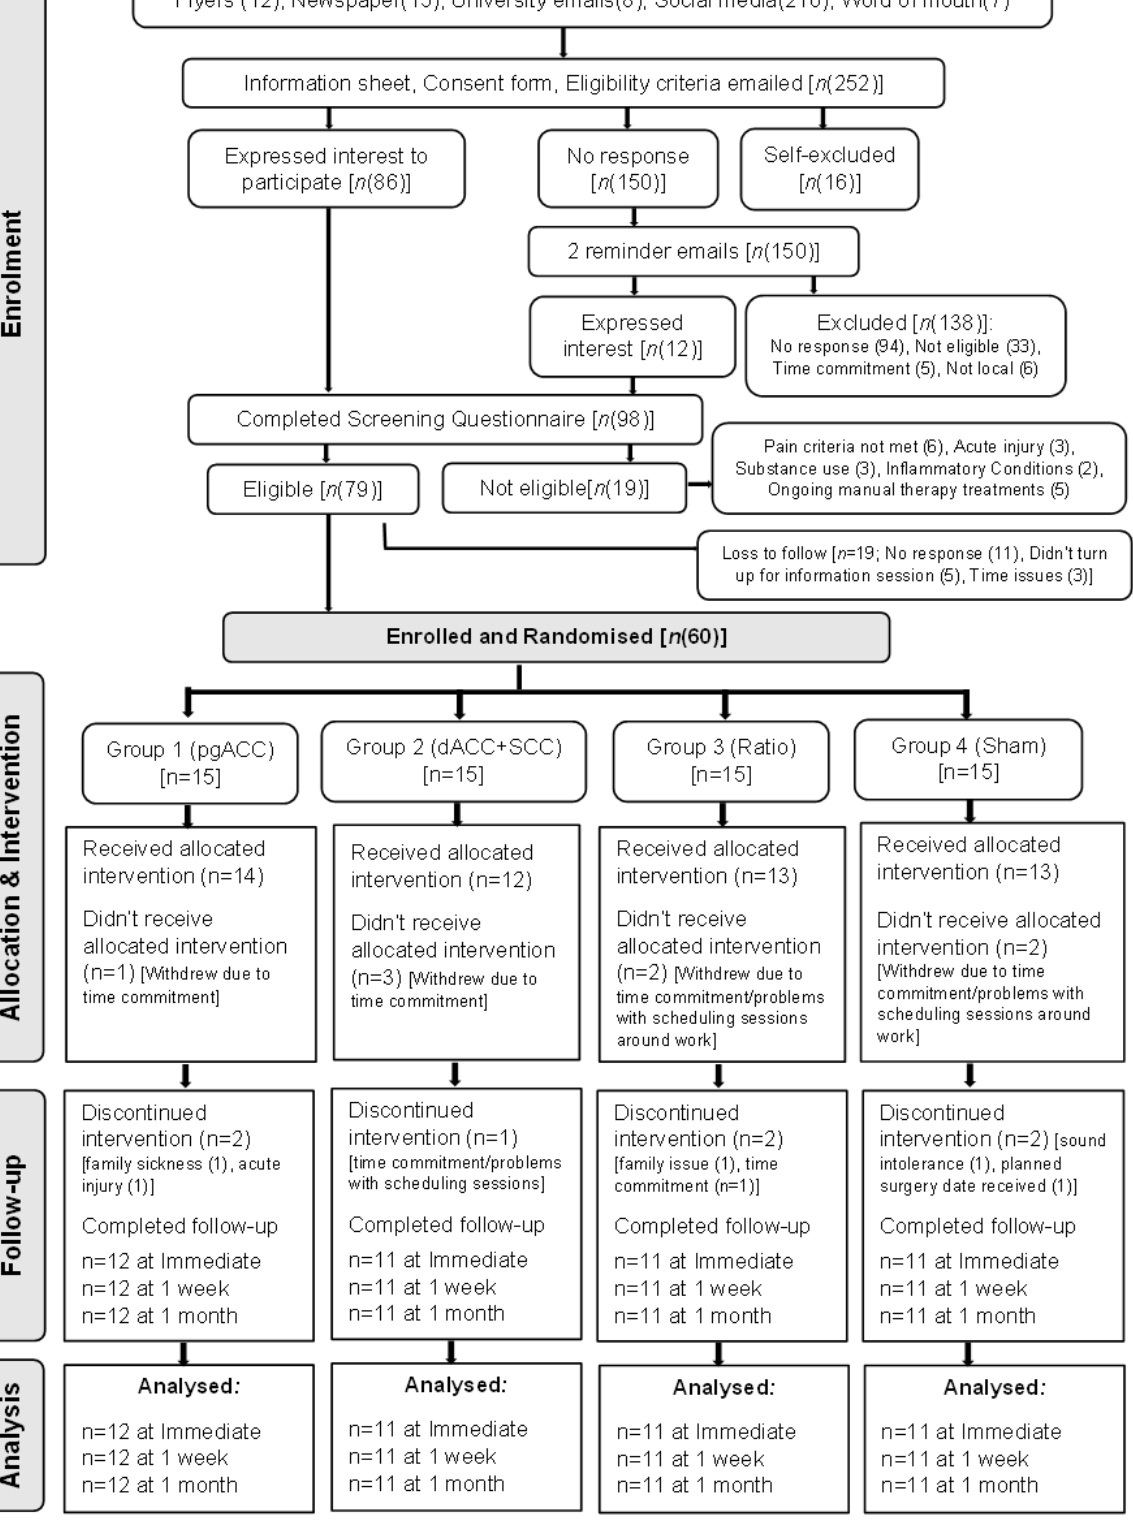
Figure 1. Flow of participants through the study phases. pgACC: pregenual anterior cingulate cortex; dACC: dorsal anterior cingulate cortex; SSC: primary somatosensory cortex (S1).